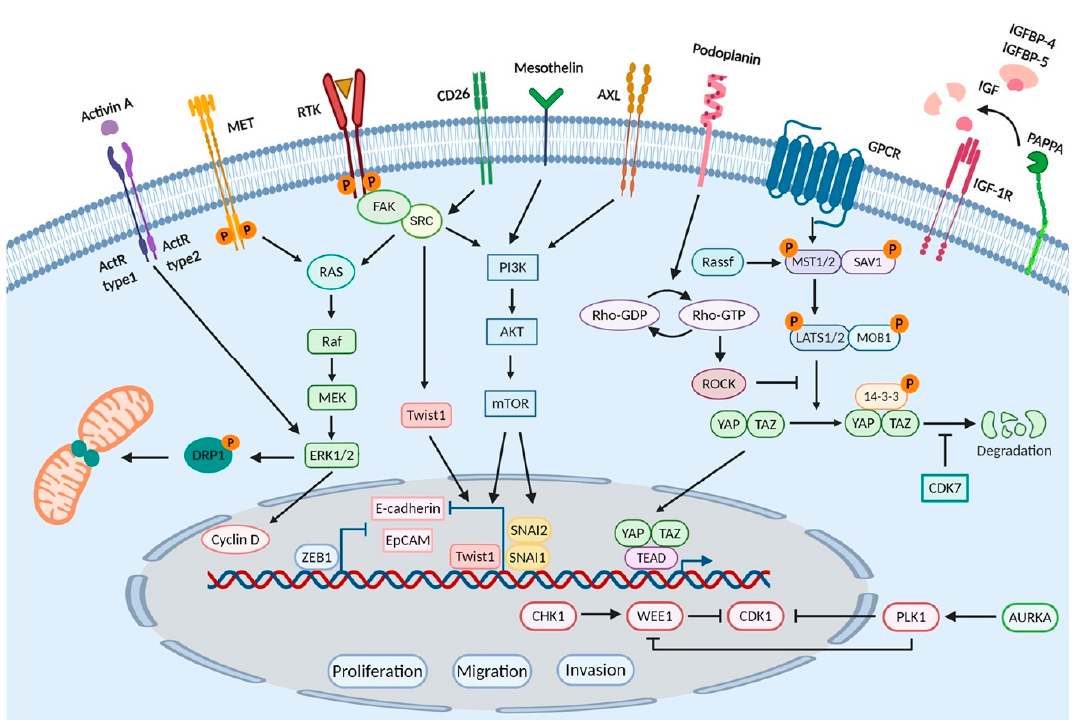
Figure 1. An outline of molecular mechanisms implicated in MPM pathogenesis through functional genomics studies.